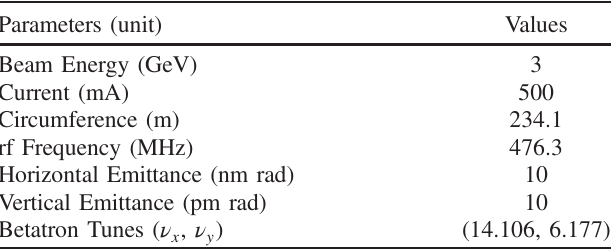
TABLE I. Main parameters of